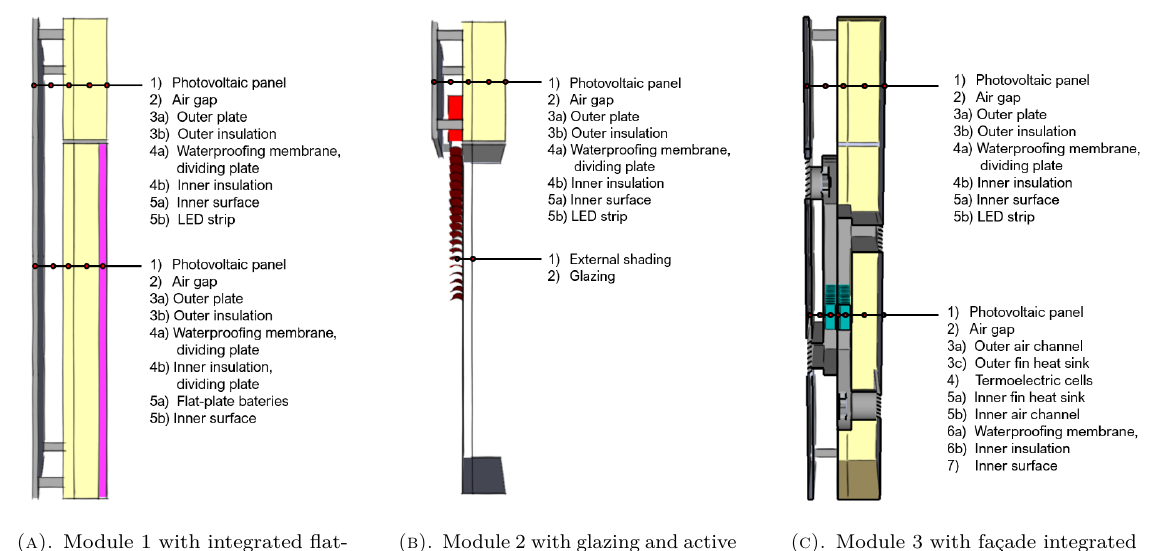
Figure 2. Unit design – section view of